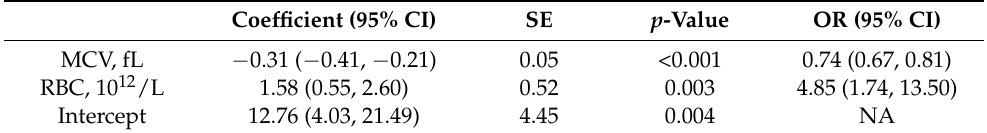
Table 4. Regression model summary of the multibiomarker model for predicting presence of the ho- mozygous EE disorder. Coefficient (95% CI) SE p -Value OR (95% CI) MCV,